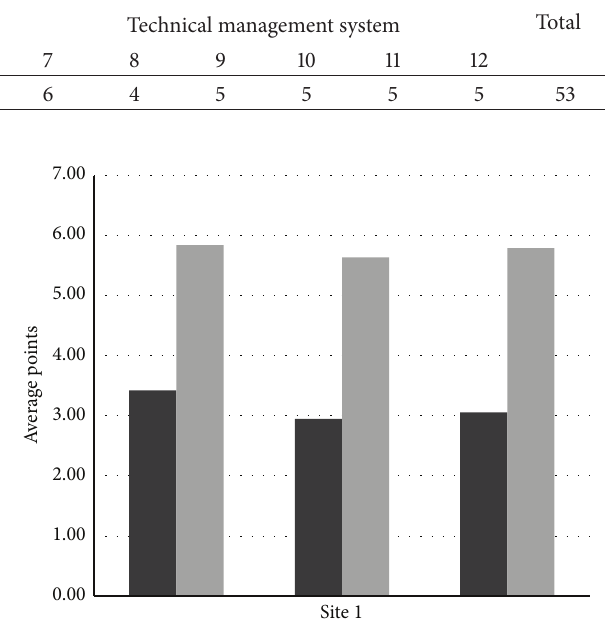
Figure 1: Graph showing effectiveness of the program at site